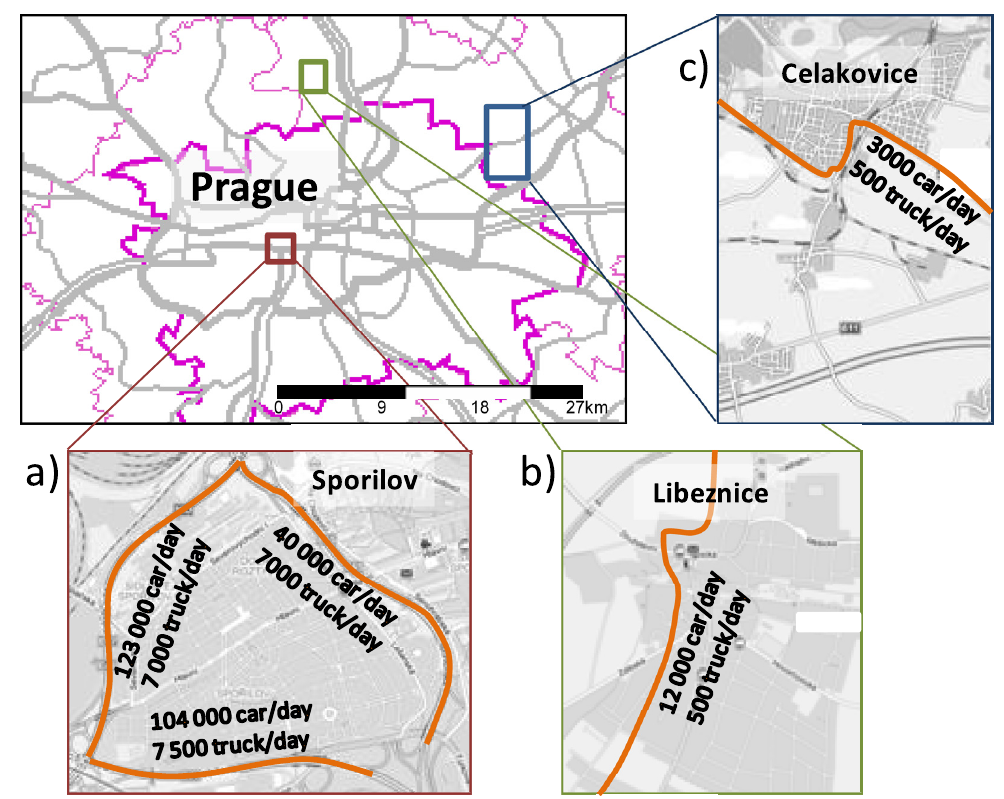
Figure 2. Location of measurement sites with given traffic density: ( a ) Spo ř ilov, ( b ) Libeznice, and ( c ) Celakovice. Map sources: Geofond, Czech Geological Survey; Mapy.cz, Seznam.cz